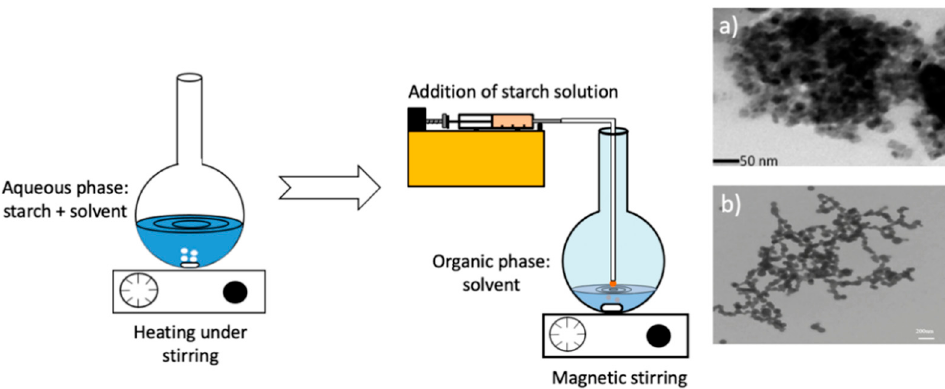
Figure 2. Synthesis of SNPs through nanoprecipitation method and TEM micrographs of corn SNPs ( a ) [14] and ( b ) [15]. Reprinted from [14] with permission from Elsevier. Copyright (2015).